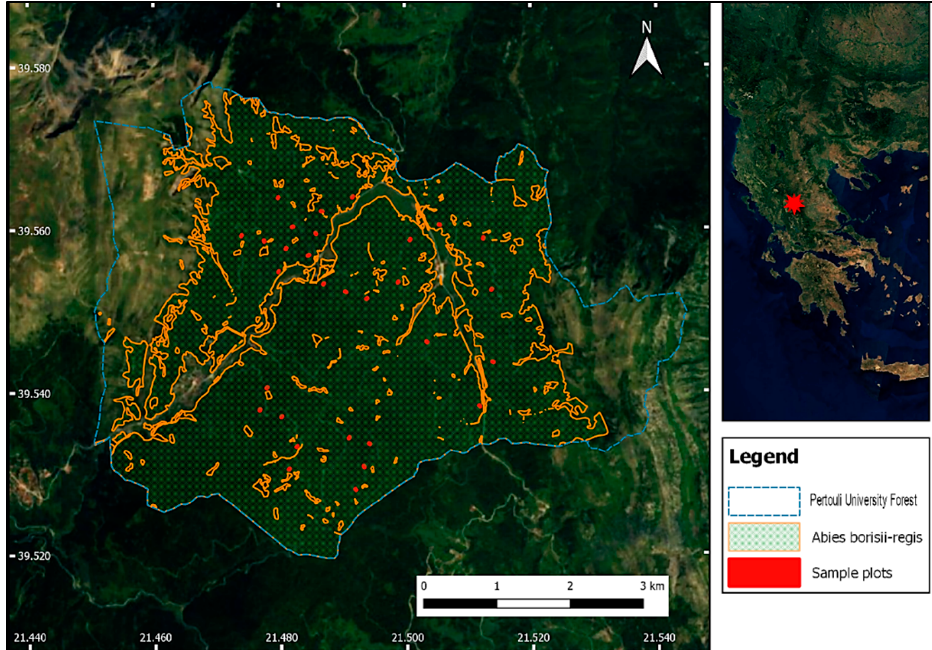
Figure 1. Map of the study area, including the sample plots’ location and the boundaries of the Abies borisii-regis cover.